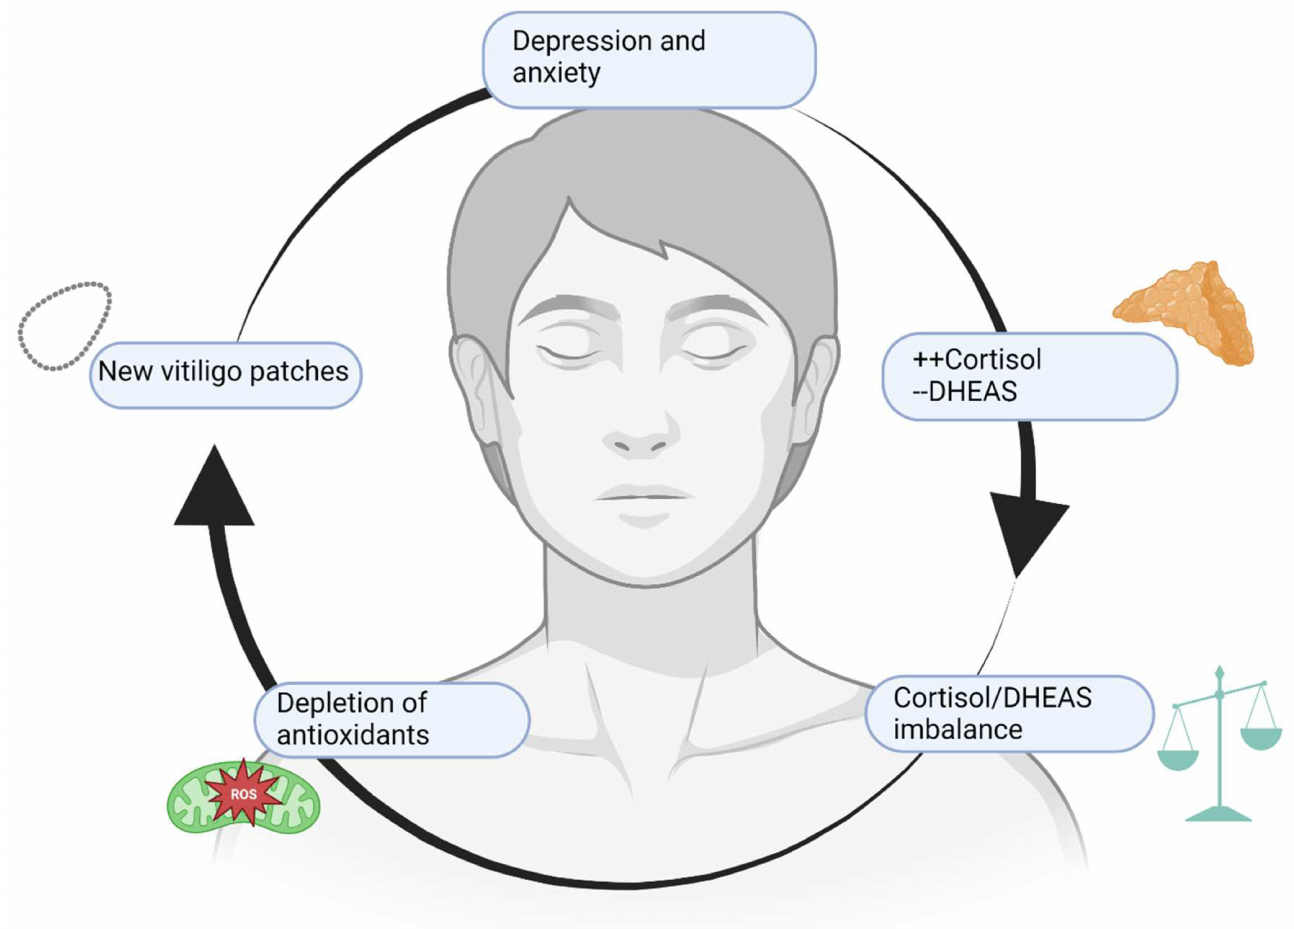
Figure 2. A vicious cycle. Depression and anxiety, along with other MH issues, raise cortisol levels and reduce DHEAS levels. The consequent imbalance leads to a reduction of defense mechanisms and redox potential, heightening local and systemic levels of inflammation with worsening and multiplication of vitiligo patches. If located on exposed or intimate areas, vitiligo lesions lead to stress and concern about physical appearance, worsening depressive and anxiety symptoms. Created with BioRender.com (accessed on 1 November